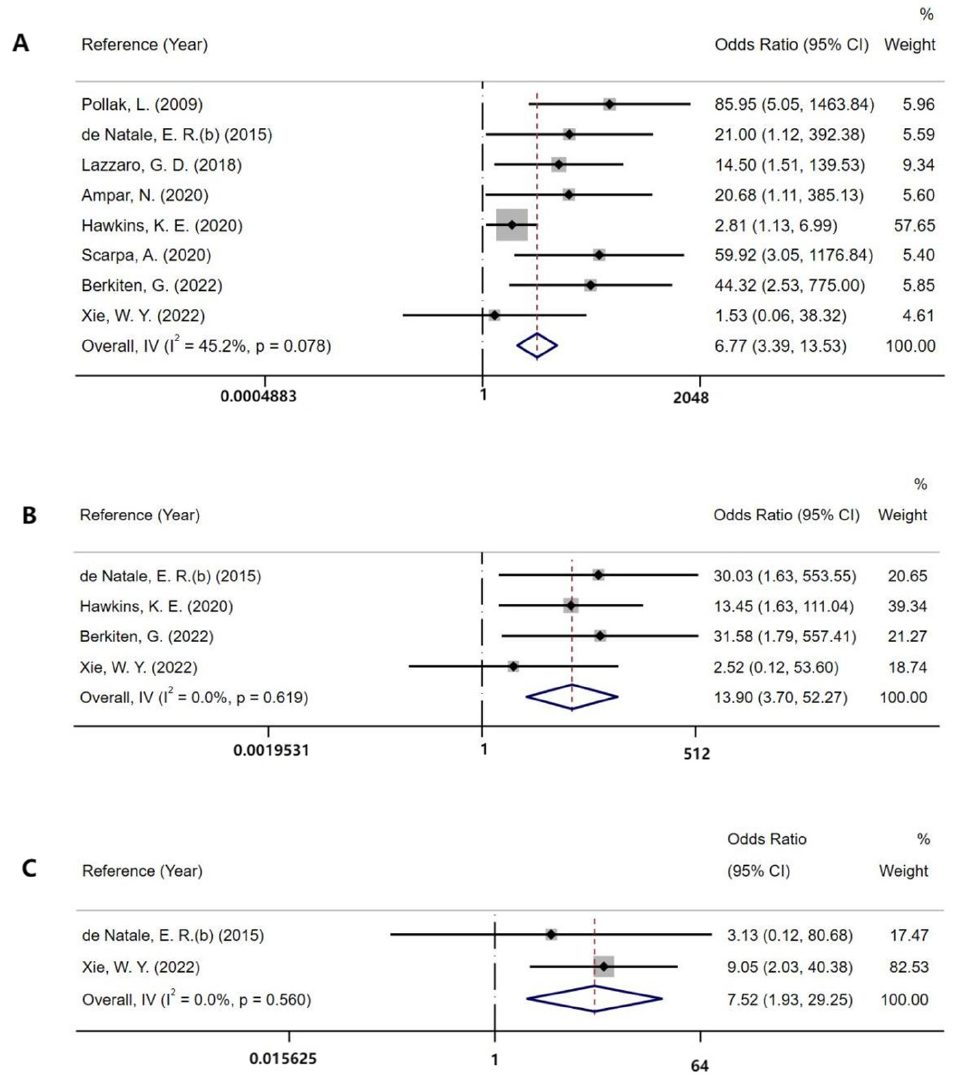
Figure 2. Forest plot of absent VEMP responses in patients with PD: ( A ) the absence rate of cVEMP [6,7,11,15,22,25–27]; ( B ) the absence rate of oVEMP [7,11,15,26]; ( C ) the absence rate of mVEMP [11,15].